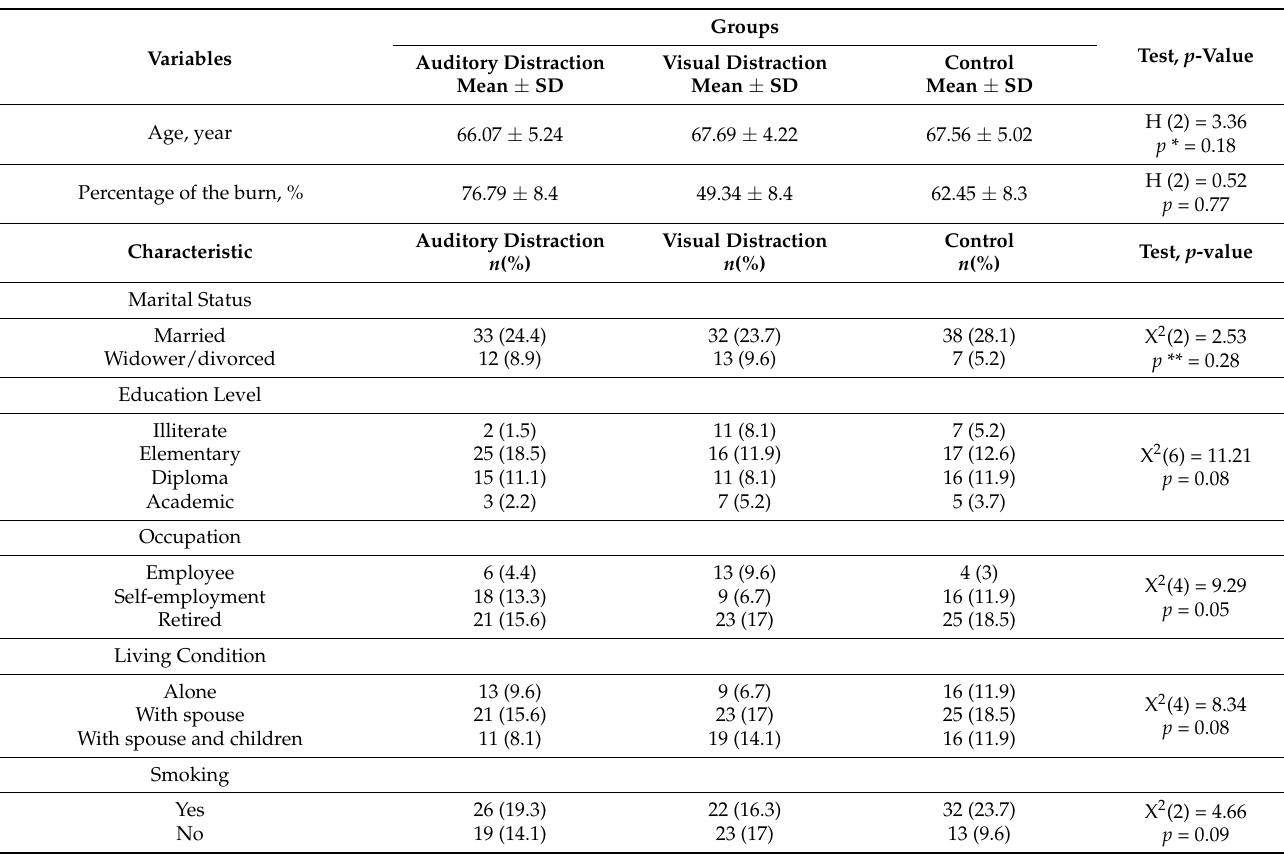
Table 1. Comparison of the demographic characteristics of the participants between the groups ( n =